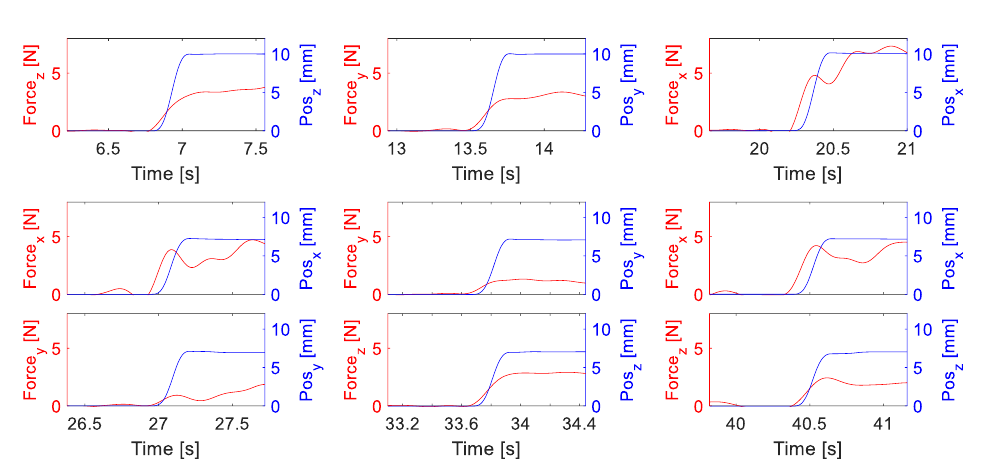
Figure 5. Typical results of a perturbation experiment to identify the arm endpoint stiffness matrix. The displacement profile (blue) and the measured reaction forces (red) are illustrated for one selected trial. Subplots in the first row from left to right represent perturbation in z , y and x directions, respectively. Subplots in the columns of the remaining two rows from left to right represent perturbations in x − y , y − z and x − z directions,